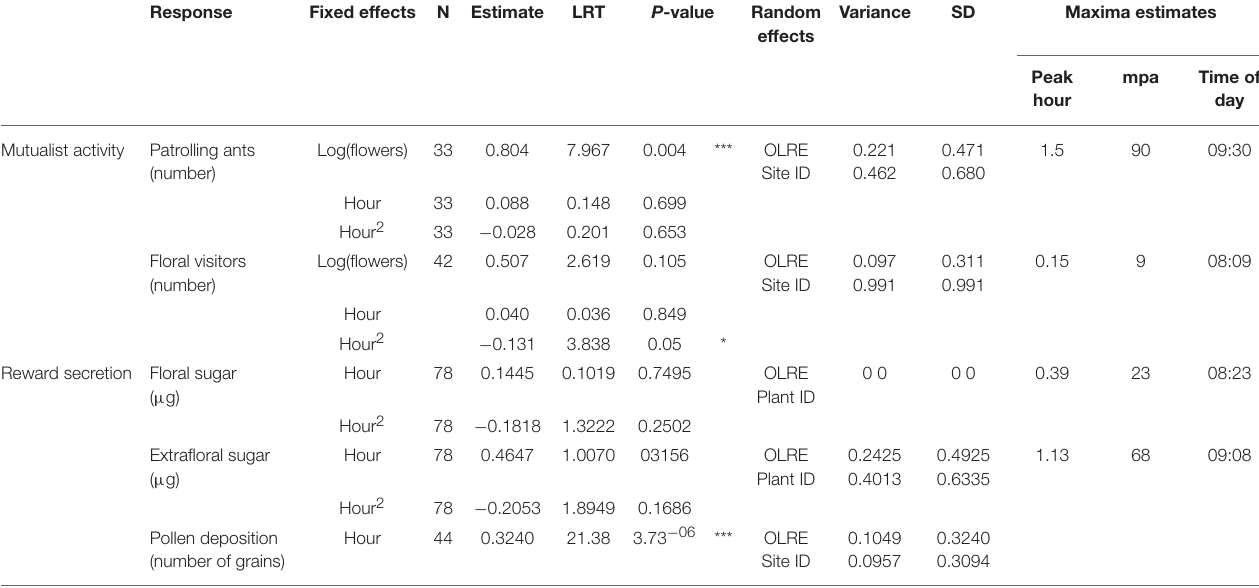
TABLE 1 | Model statistics for the timing of mutualists activity, reward secretion and pollen deposition in Turnera velutina . Response Fixed effects N Estimate LRT P -value Random